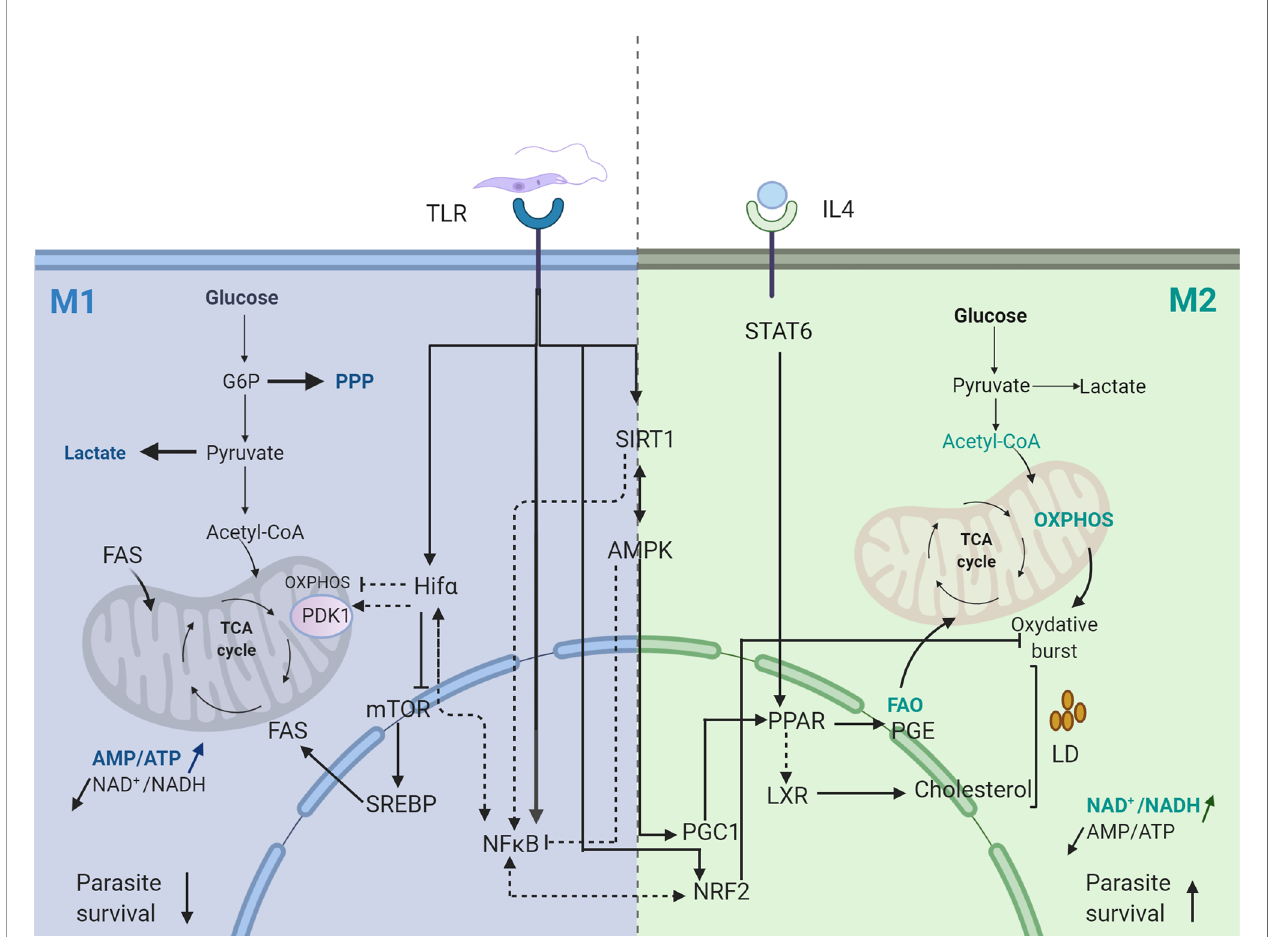
FIGURE 1 | Transcriptional signature of Leishmania infected macrophage. Dotted arrows represent pathways not validated in Leishmania infected macrophages. Straight arrows represent pathways validated in Leishmania infected macrophages. FAS, Fatty Acid Synthesis; FAO, Fatty Acid Oxydation; PGE, Prostaglandine E; PPP, Pentose Phosphate Pathway; OXPHOS, Oxidative Phosphorylation. Created with